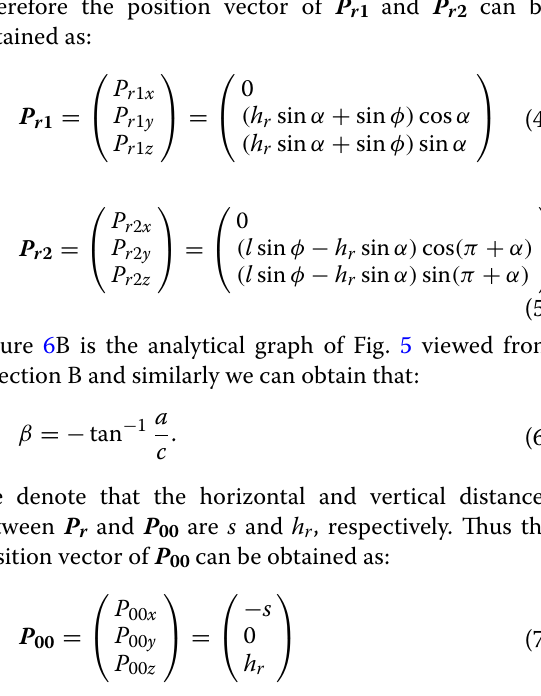
Figure 6A and B are analytical graphs of Fig. 5 viewed from direction A (the view from x direction) and B (the view from y direction). Aforementioned, plane 2 con- tains the axis of the passive joint and the normal vector of plane 1, thus plane 2 can be expressed as y the normal vector of plane 3 as n = [ a b c ] obtain: